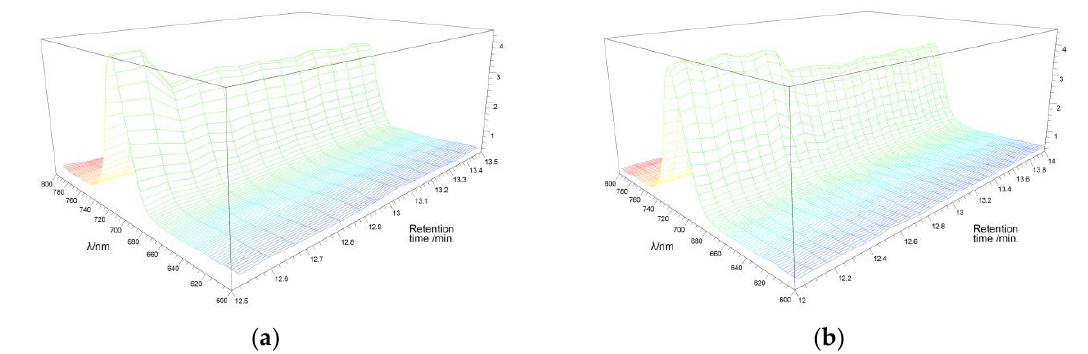
Figure 8. Three-dimensional emission spectra of: squaraines 4b ( a ) and 5b ( b ).